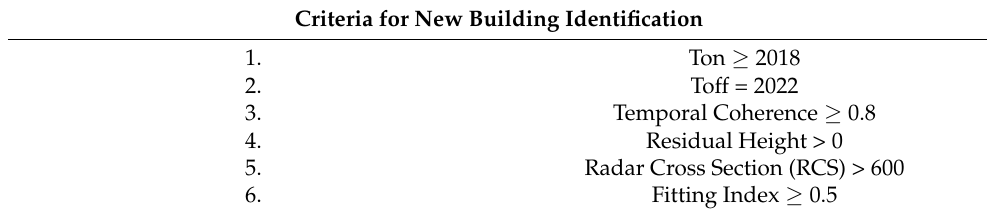
Table 4. The proposed criteria aim to highlight newly constructed